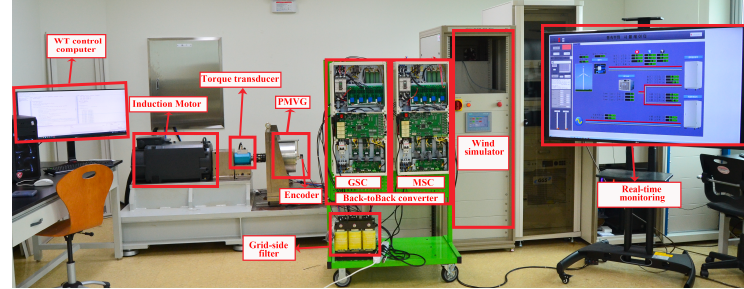
Figure 16. Hardware of the experimental setup.